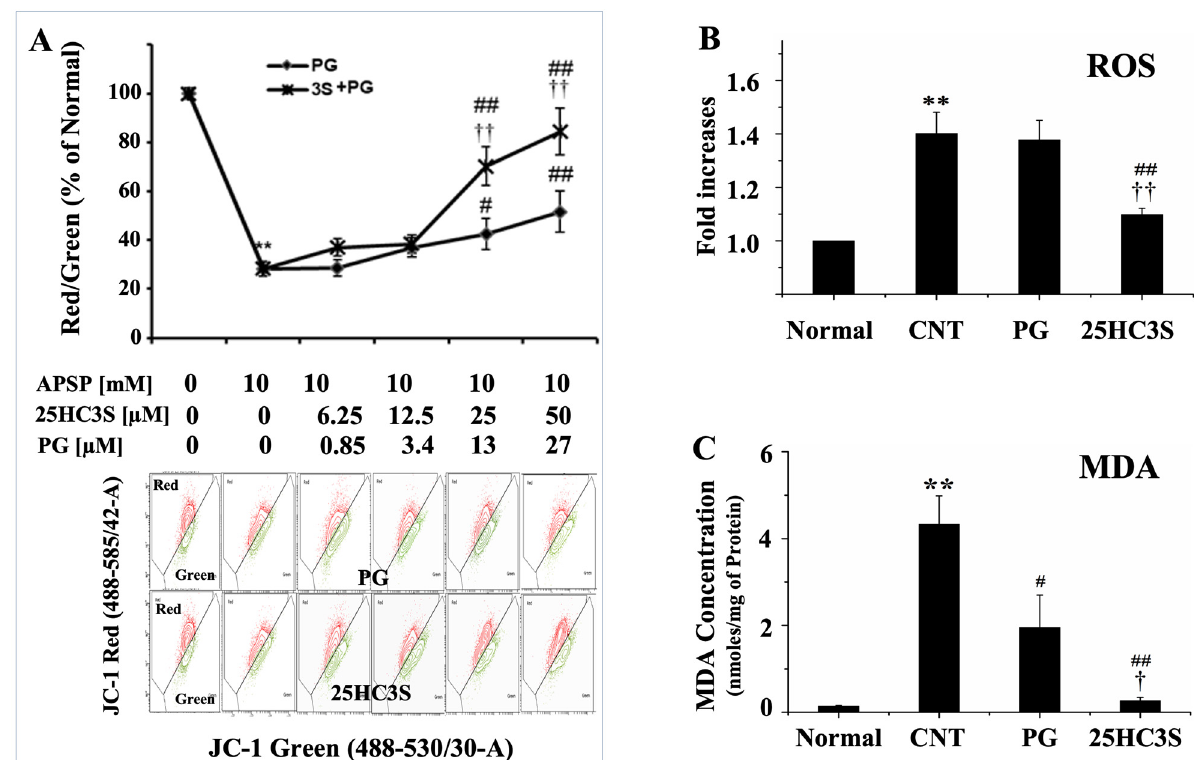
Figure 5. 25HC3S restores the injured mitochondria membrane potential and decreases oxidant levels. ( A ) shows effects of 25HC3S on mitochondrial polarization, Huh-7 cells were seeded in 60 mm dishes at 6.5 × 10 5 /dish and cultured overnight before different dosages of 25HC3S (6.25, 12.5, 25, 50 µ M in PG) were added, the relative amount PG were added as control (0.85, 3.4, 13, and 27 μ M). Two hours later, cells were treated with 10 mM APAP for 24 h and harvested. Cells without any treatment were used as control. MMP was analyzed by JC-1 staining on flow cytometer using 488 nm excita- tion with 530/30 nm (Green) and 585/42 nm (Red) band-pass emission filters. MMP was indicated by red/green fluores- cence ratio. ( B ) shows 25HC3S significantly decreases ROS levels in Huh-7 cells. Huh-7 cells were pretreated with the 50 μ M 25HC3S and/or vehicle for 2 h before 10 mM APAP was added. Sixteen hours after APAP addition, the cells were harvested. H2DCFDA method was used to detect ROS levels by flow cytometry. Results were expressed as the relative changes compared to untreated cells. ( C ) shows MDA levels in liver tissues. Mice were challenged with 350 mg/kg APAP for 30 min and treated with 25 mg/kg 25HC3S for 24 h. The liver tissues were harvested and ~100 mg was homogenized.